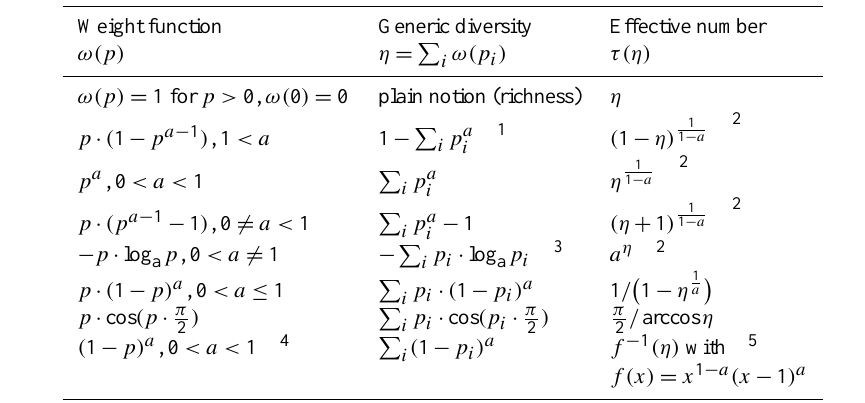
Table 1. Examples of strictly concave weight functions ω(p) together with their respective generic diversities η and strictly increasing transformations τ that make τ(η) into diversity effective numbers; p i := relative representation of the i th type (only p i > 0